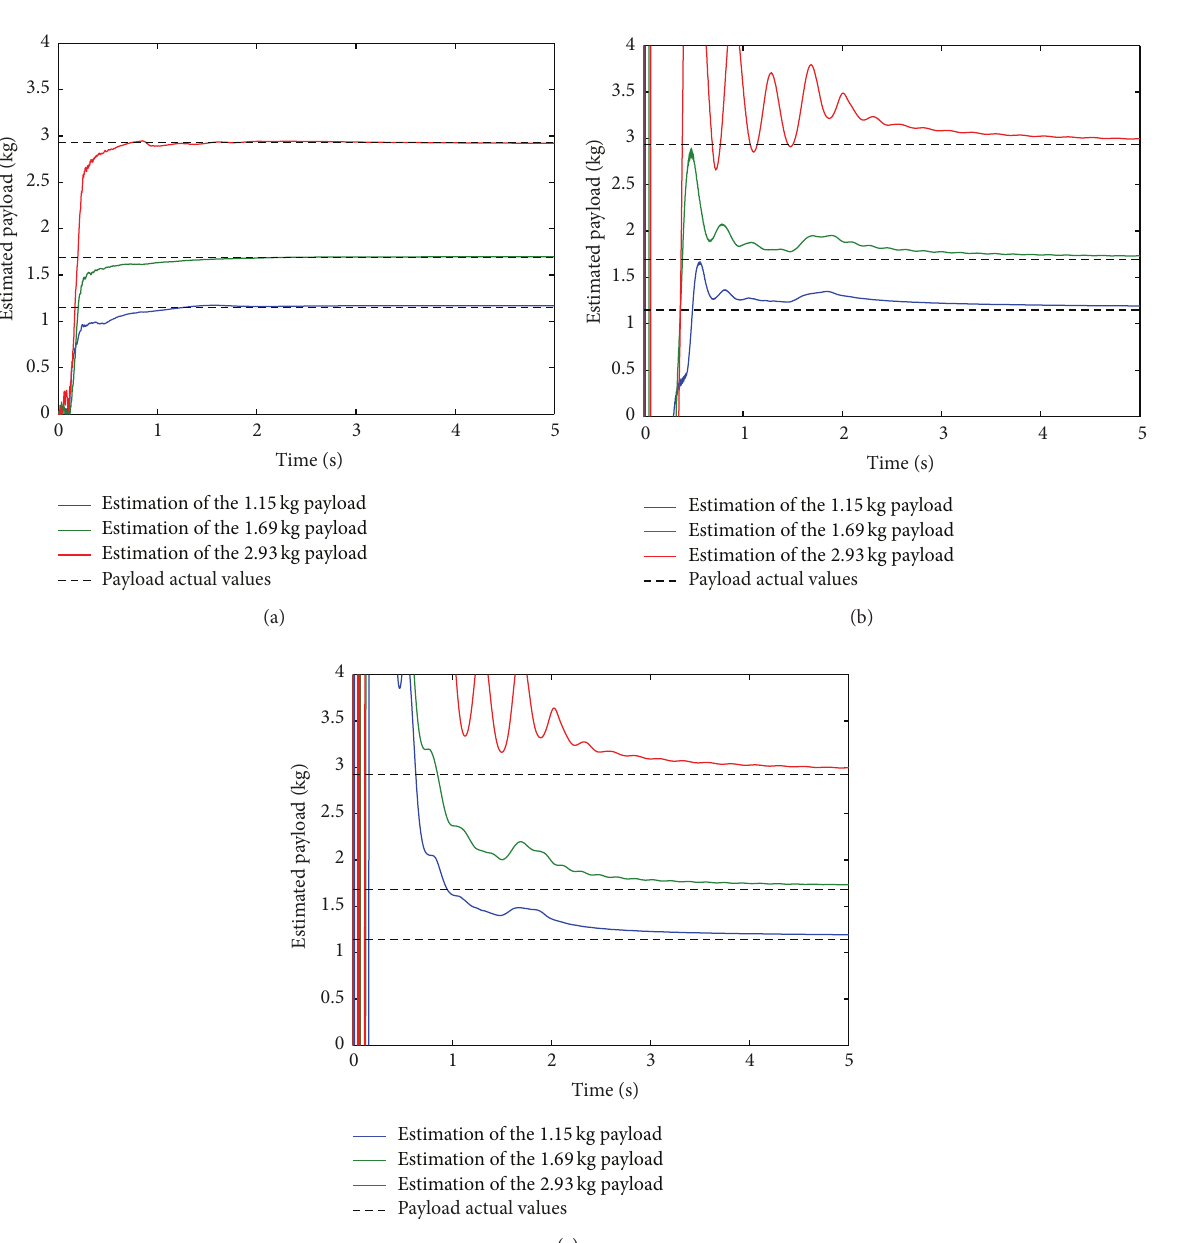
Figure 8: Experiment type 1: (a) algebraic identifier, (b) least square fitting, and (c) least square fitting with